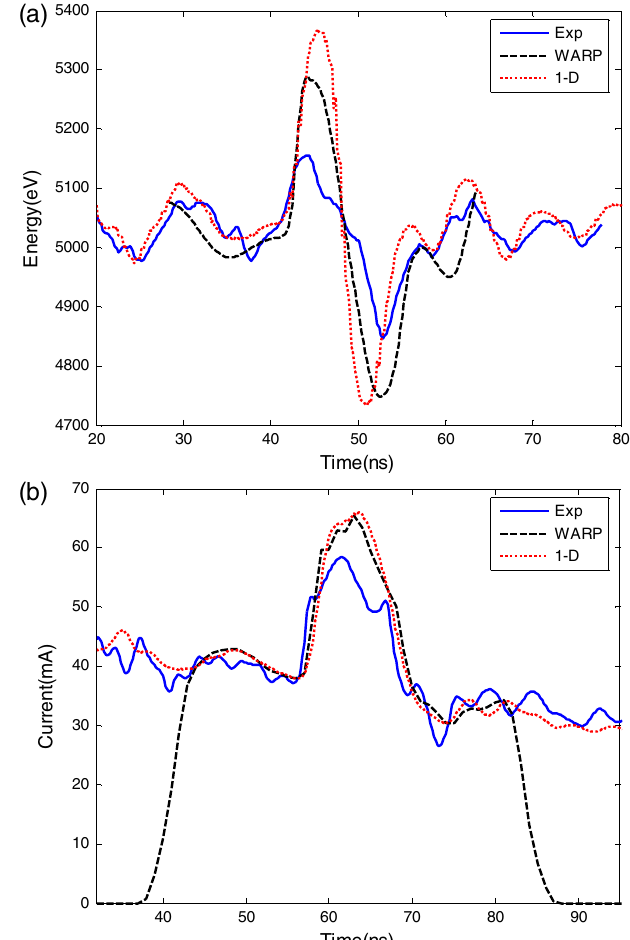
FIG. 9. (Color) Comparison of results from the experiment (blue solid lines), WARP (black broken lines), and 1D theory (red dotted lines) for the 40 mA beam: (a) mean energy profiles at LC2; (b) current profiles at B3. Current profiles have been flipped to show positive current values for the convenience of indicating positive